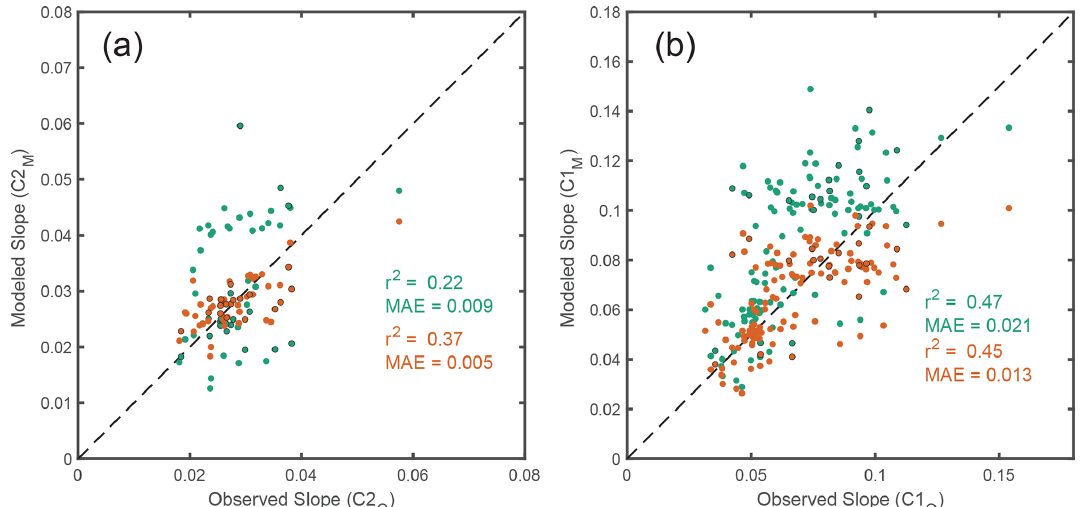
Figure 10. Comparison of observed and modeled slopes of the logarithmic density with depth for (a) stage 1 and (b) stage 2. Green circles reflect comparisons of observed slopes with those from the original densification model (Arthern et al., 2010), and the orange circles compare the same observations after calibration. Circles without an edge color are sites from Antarctica, and those with a black edge are from Greenland. Summary statistics are also color coded, where r 2 is the coefficient of determination and MAE is the mean absolute error. The dashed black line is the 1 : 1 line. Note the differences in